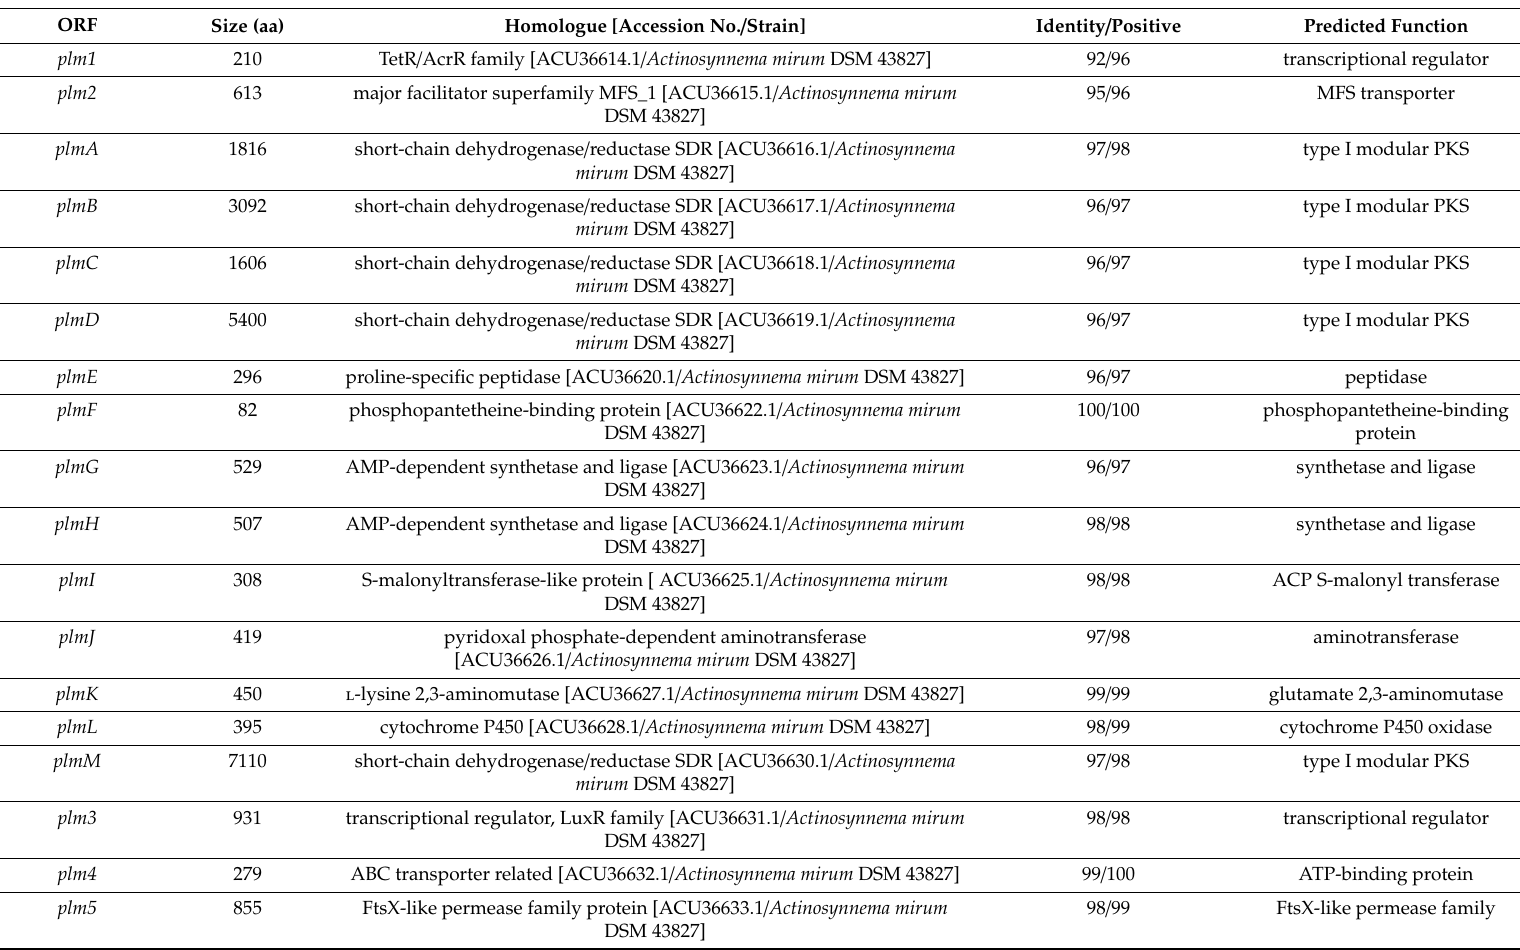
Table 1. Predicted function of ORFs from plm gene cluster for a putative polyene macrolactam (pretilactam, 1 ) in ATCC